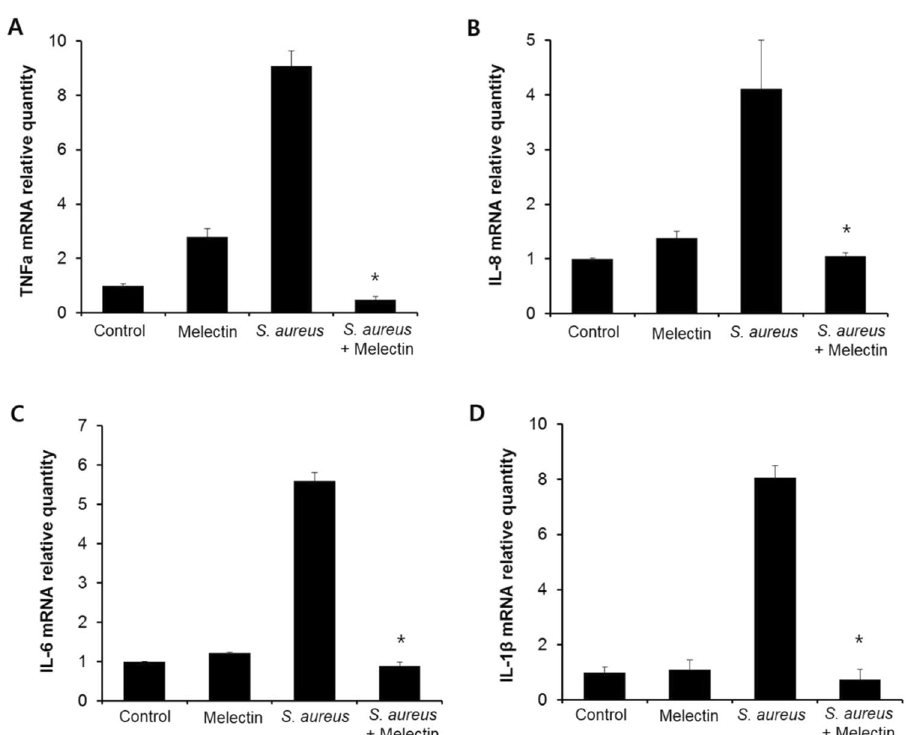
Figure 9. Effect of melectin on the release of TNF α , IL-8, IL-6, and IL-1 β . Human fibroblasts were stimulated with S. aureus ATCC 25923 in the presence of 5 µ M melectin for 24 h. Secreted TNF α , IL-8, IL-6, and IL-1 β were measured through qRT-PCR. Three independent experiments were conducted, with each experiment being performed in triplicate. Means with a difference at p < 0.05 were considered